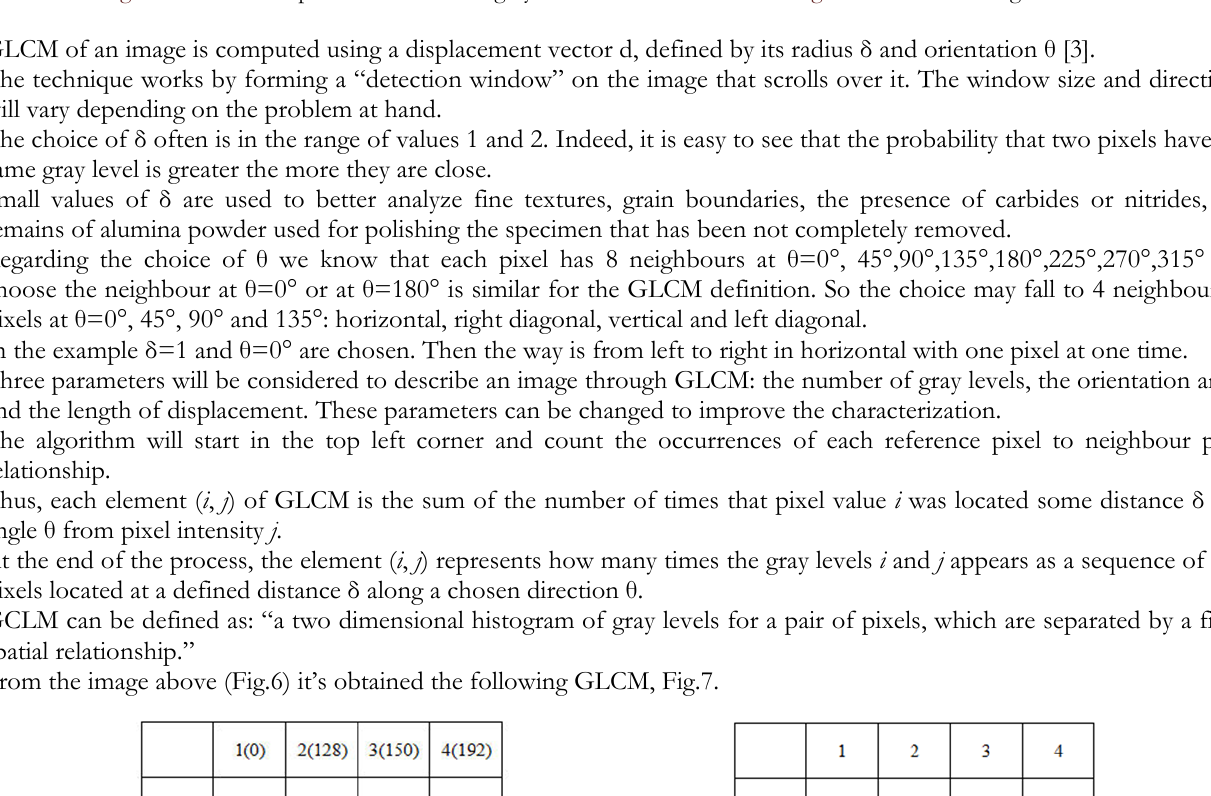
Figure 5: Matrix 4x4 pixels in 4 shades of gray. Figure 6: Matrix of image.